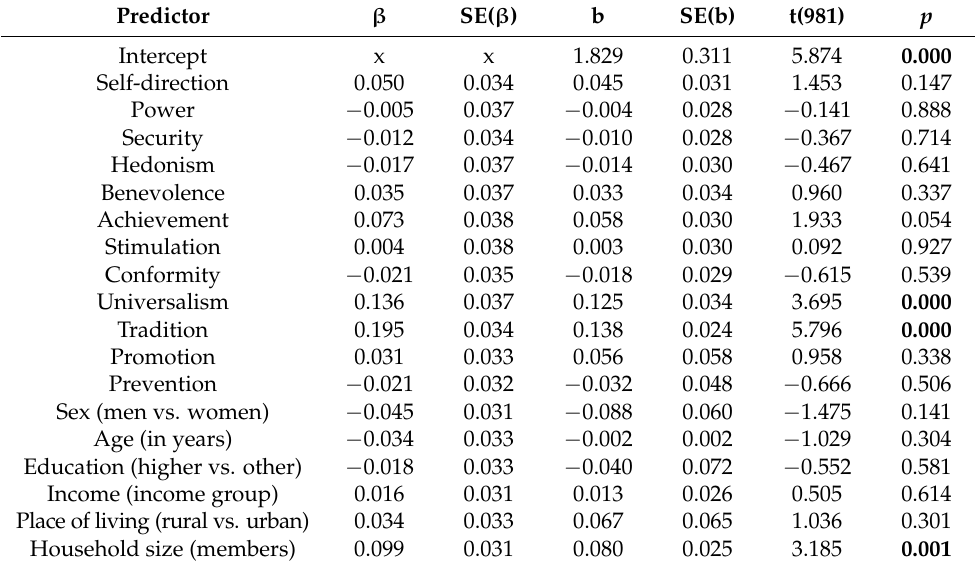
Table 7. The impact of the Schwartz values and regulatory focus on the WTP a price premium for domestic food products in the whole sample with control